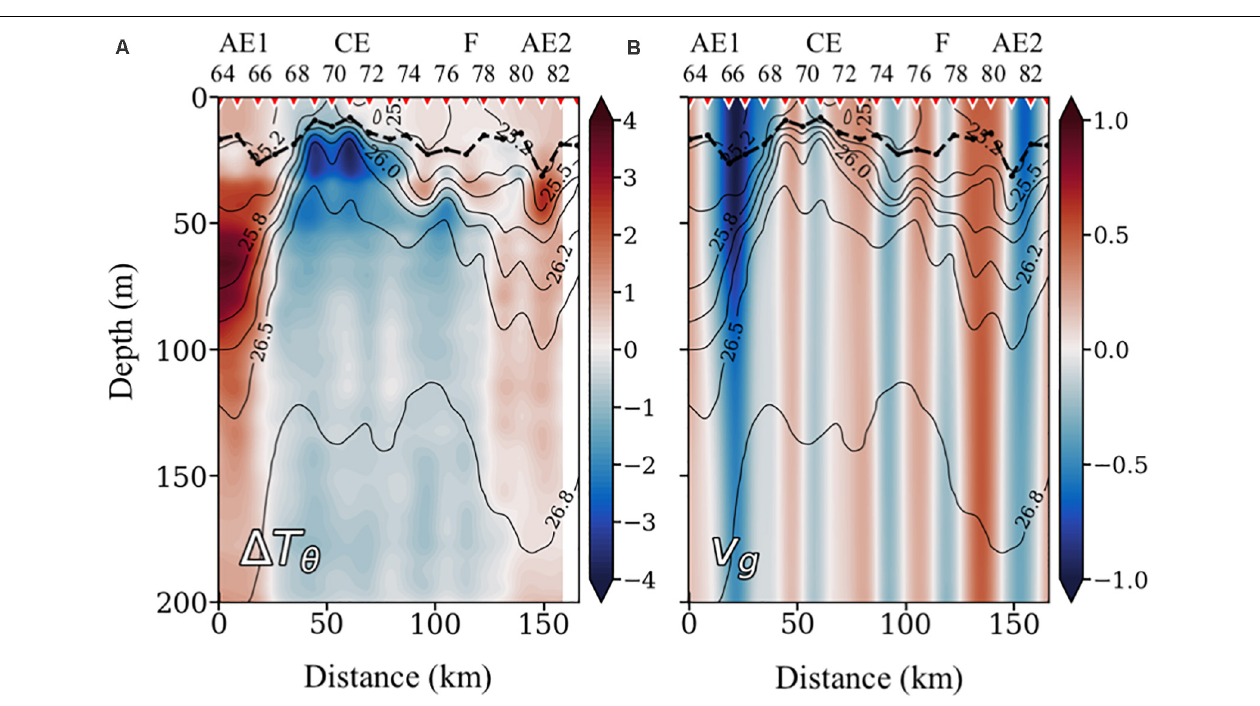
64–67 and 81–83, as well as other signatures (see below), indicate the presence of AE1 and AE2,